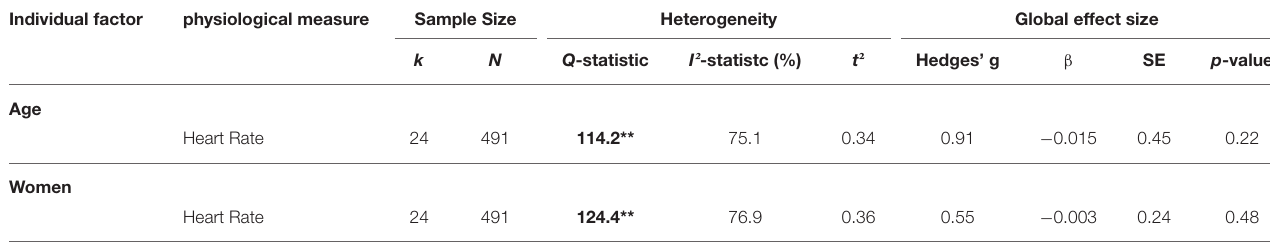
TABLE 2 | Outcomes of individual factors.